Question: What type of chart is this?
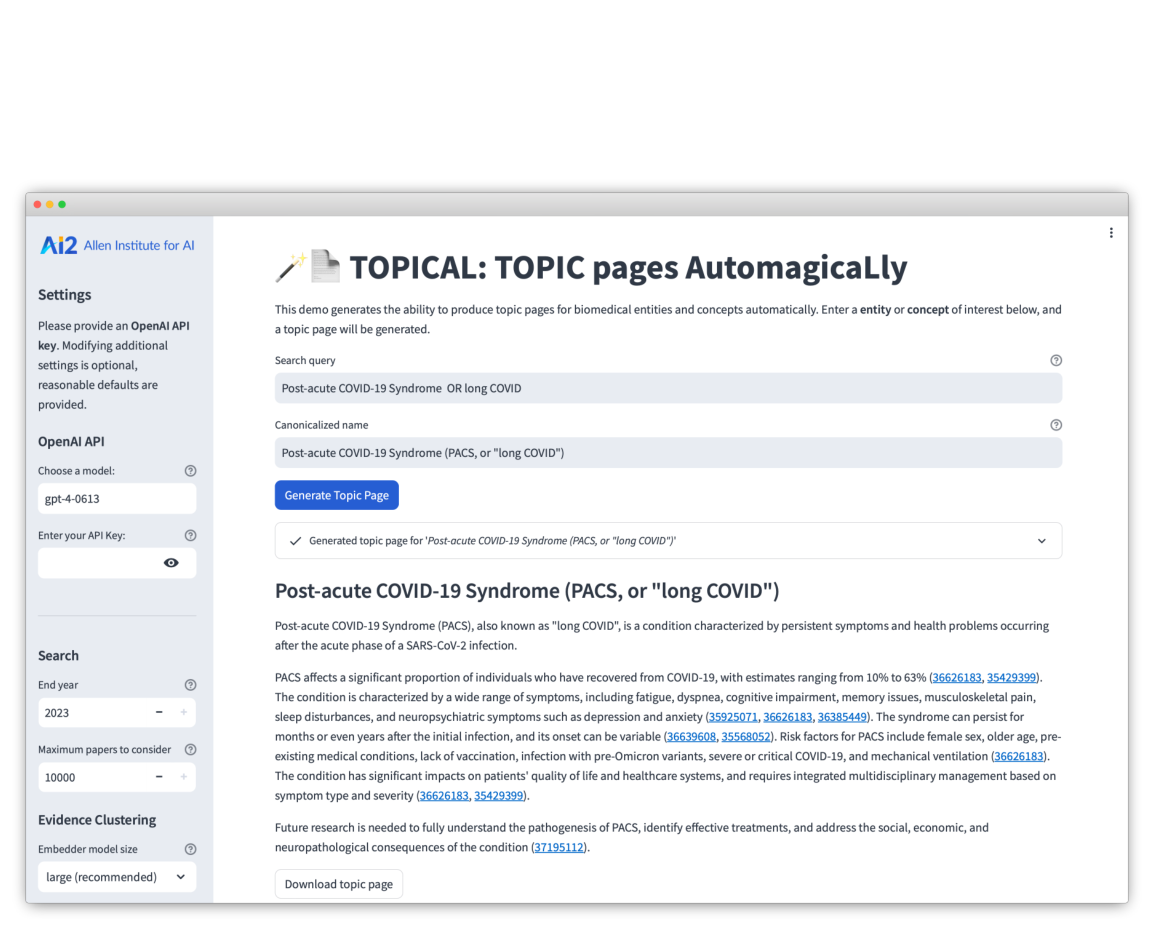
Answer: histogram